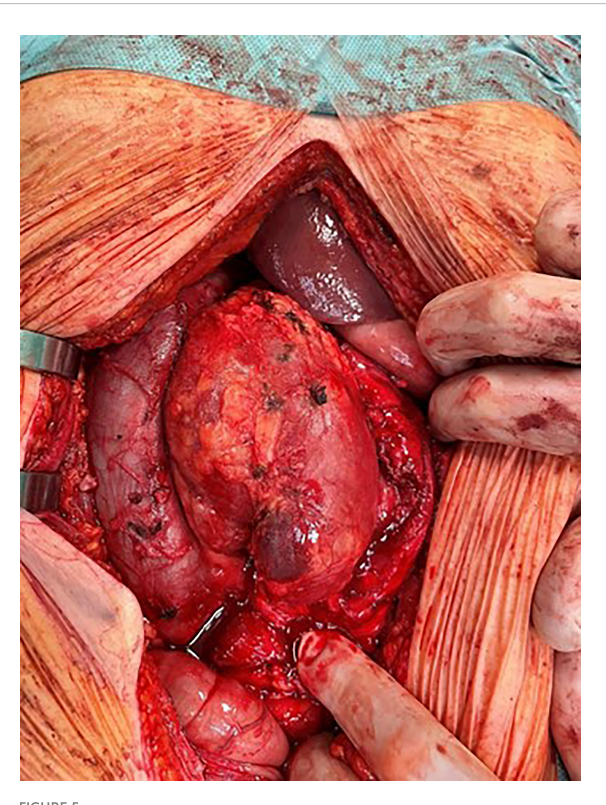
FIGURE 4 Typical fi brous capsule surrounding the lymph node in UCD.